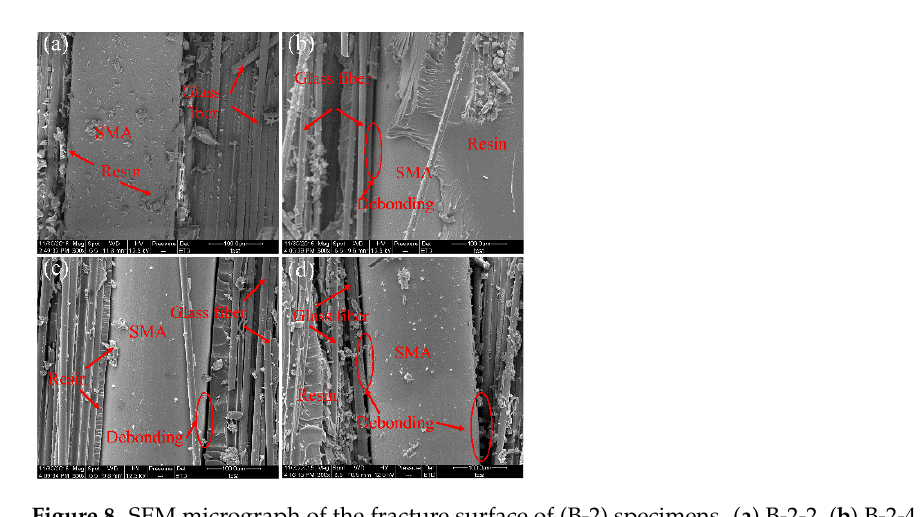
Figure 8. SEM micrograph of the fracture surface of (B-2) specimens. ( a ) B-2-2, ( b ) B-2-4, ( c ) B-2-6, ( d ) B-2-10. ( d ) B-2-10.